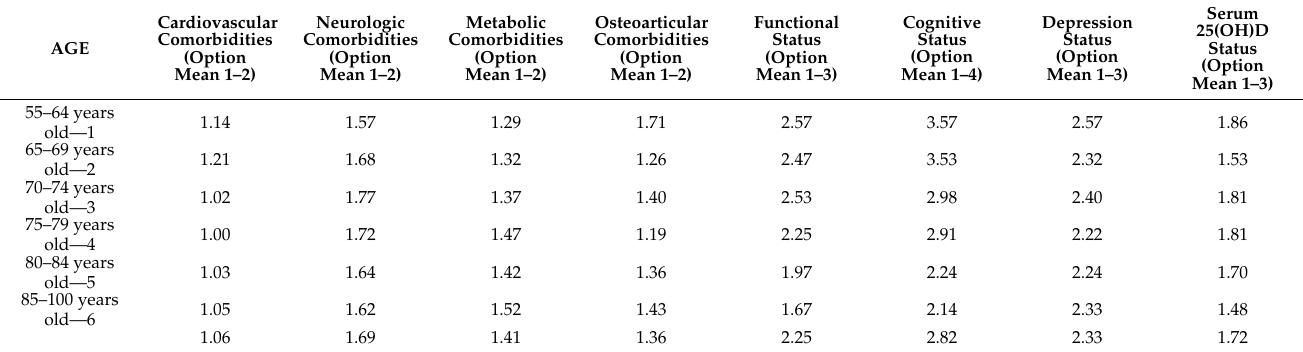
Table 8. Correlation analysis of research parameters based on age